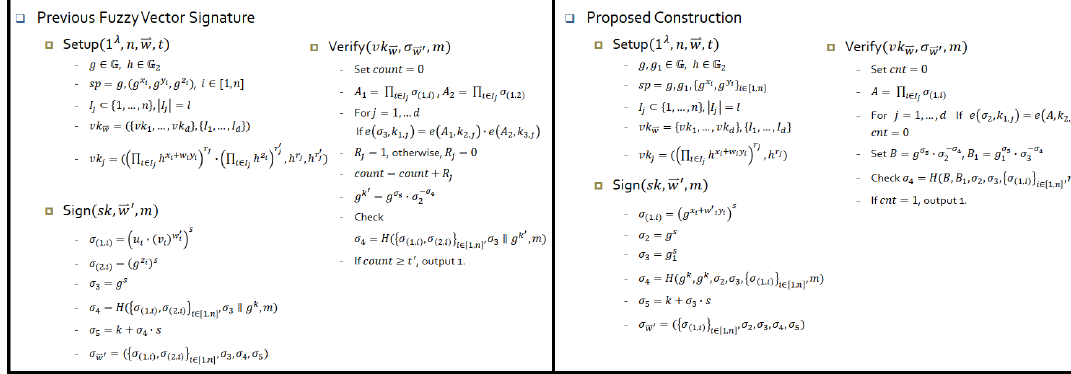
Figure 3. Comparison between previous and our